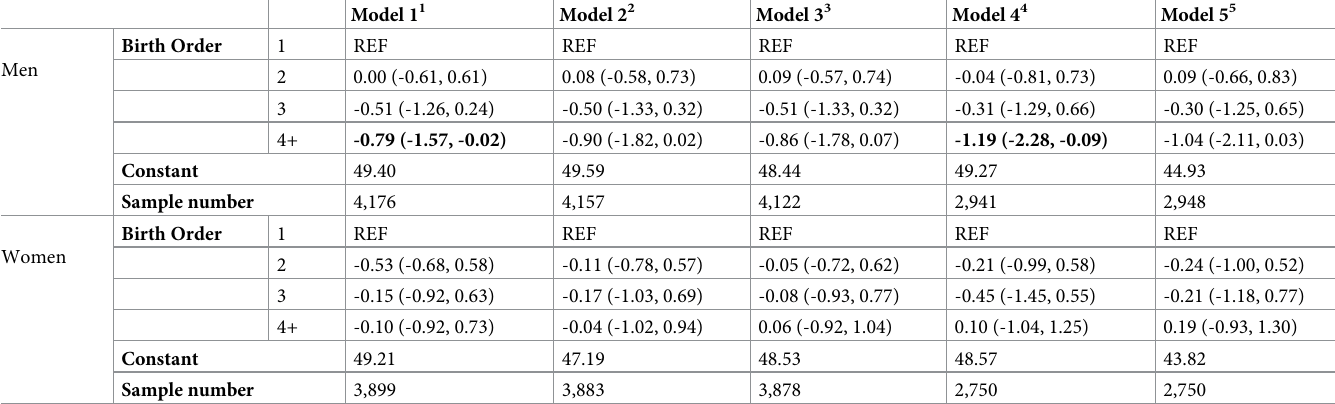
Table 5. Linear regression coefficients from models testing the association between birth order and the WEMWBS. Significant values are included in